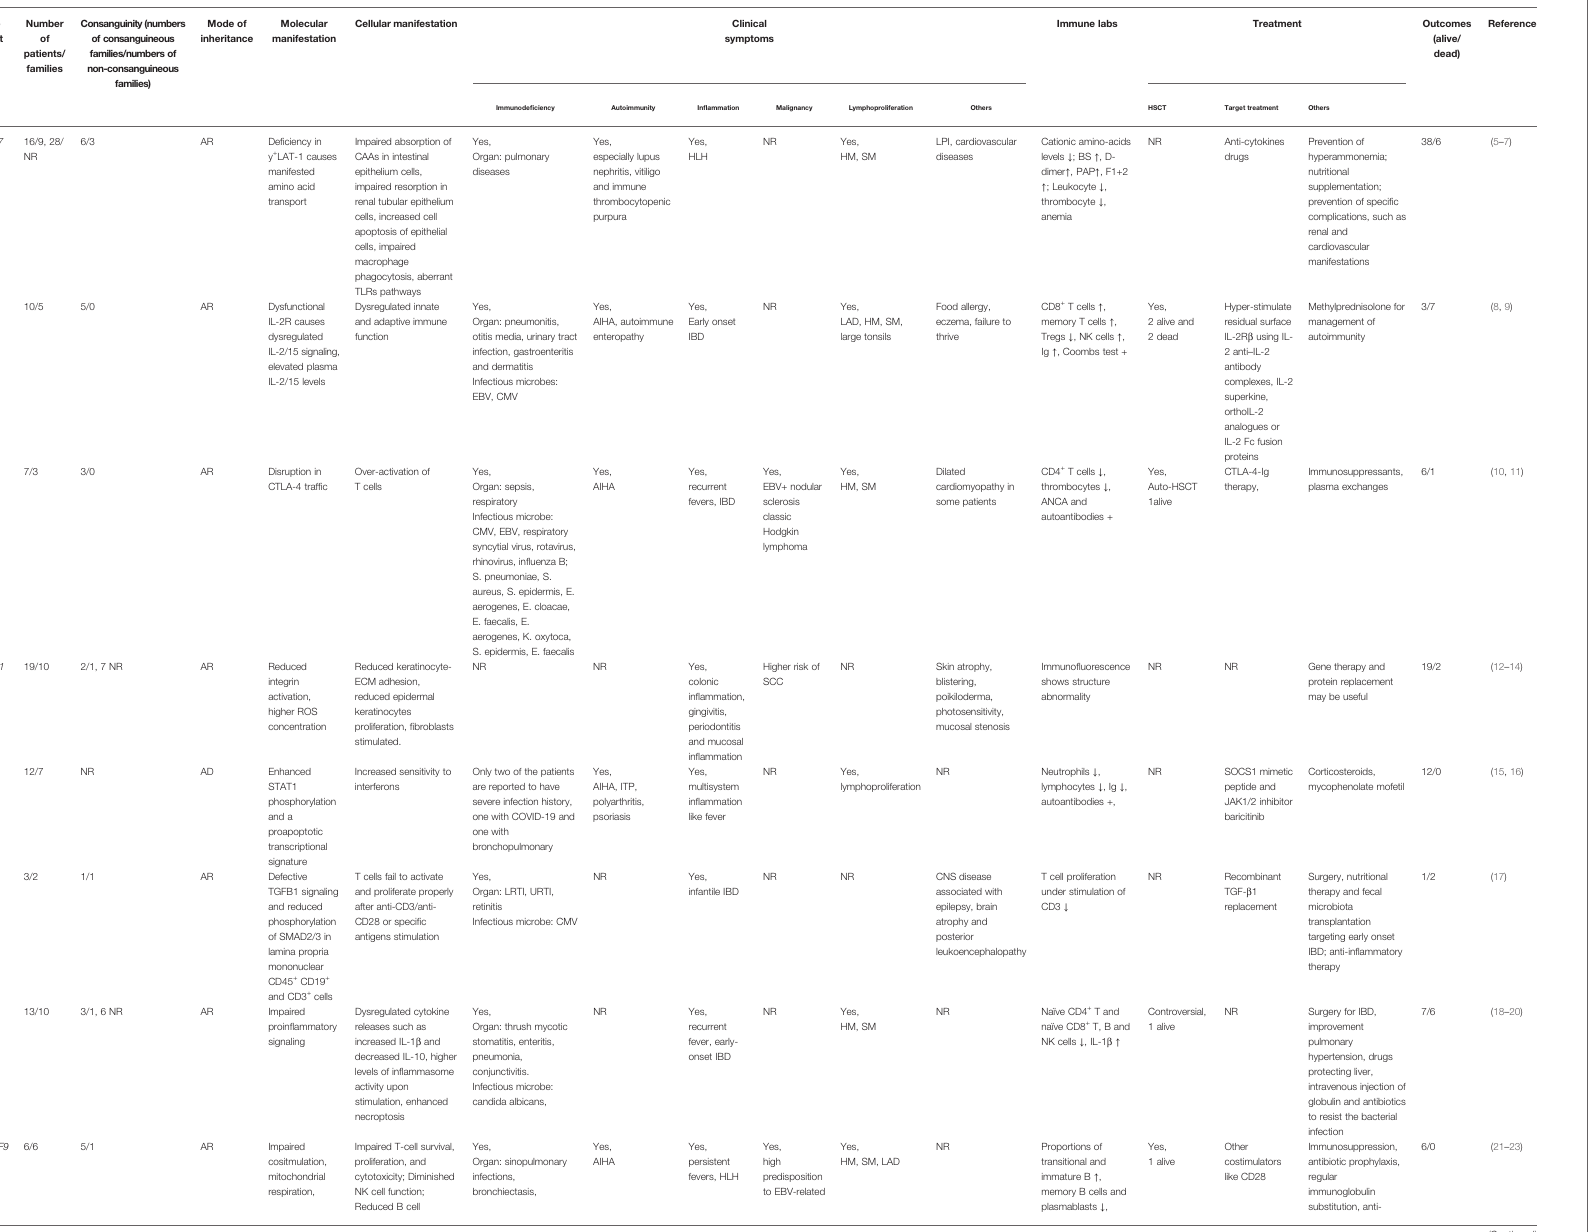
TABLE 1 | Newly reported primary immune dysregulation